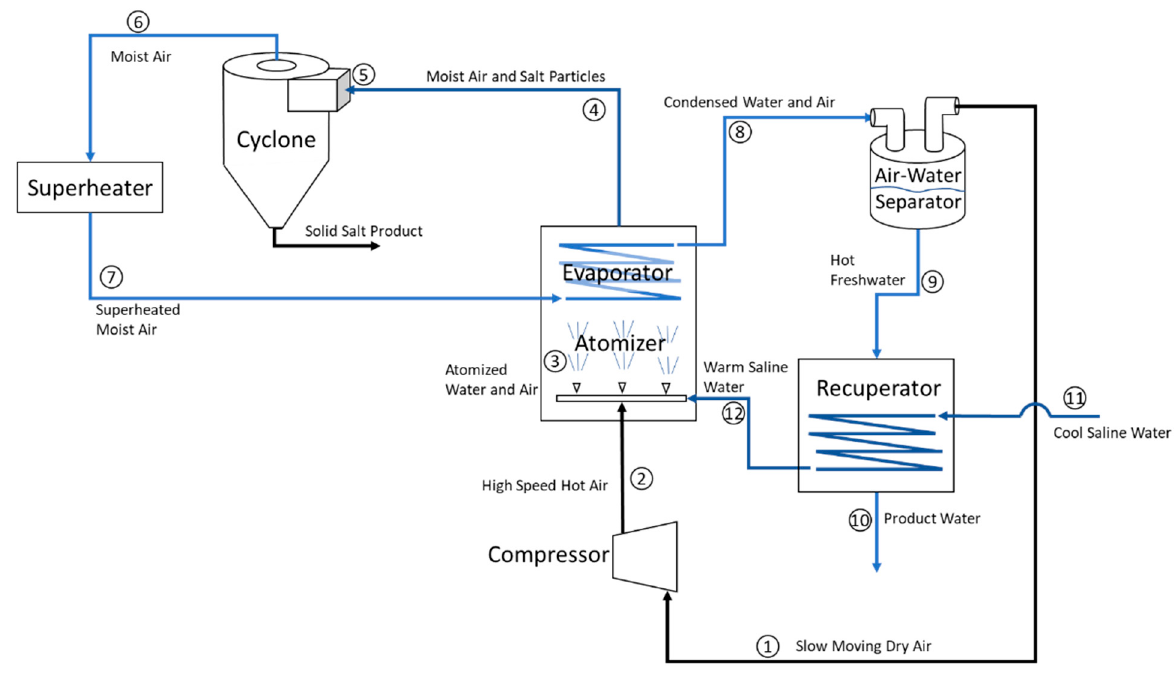
Figure 1. Diagram schematic of the proposed system.